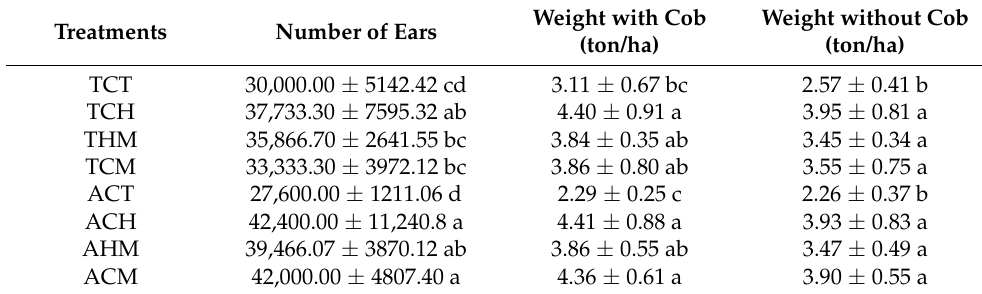
Table 6. Average corn production of each